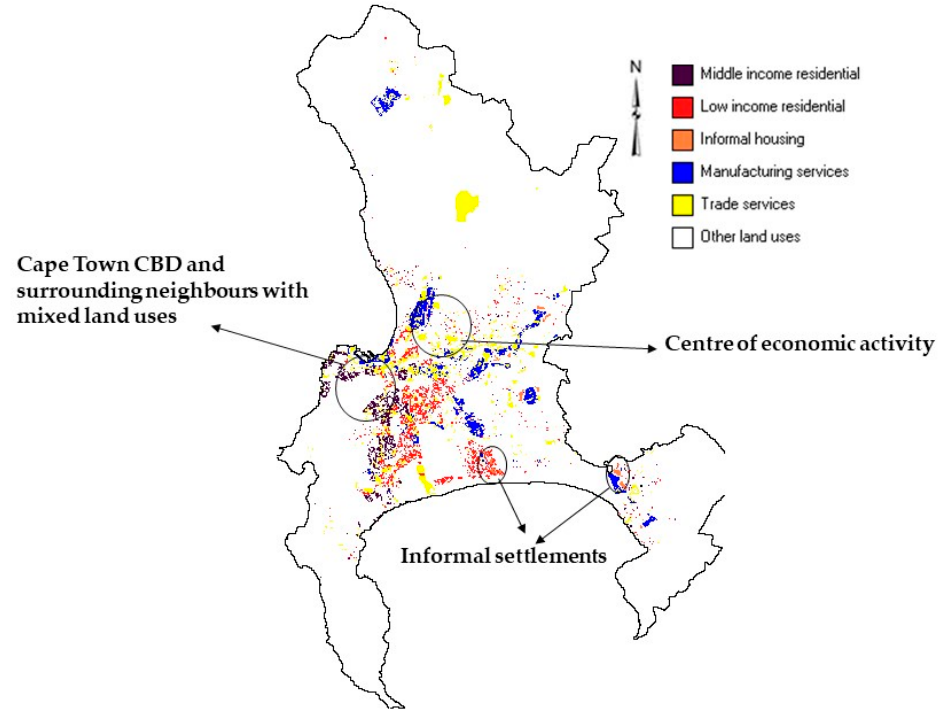
Figure 8. Location of informal settlements and low-income residential areas relative to the CBD and other centres of economic activities under the BAU scenario.